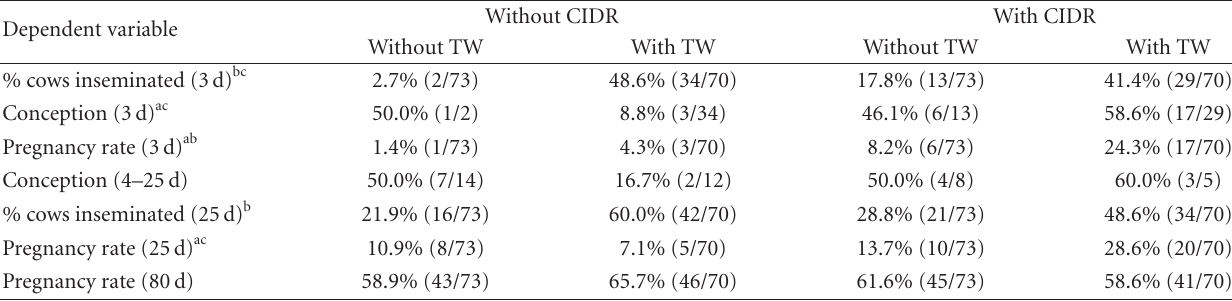
Table 1: Percentage of cows inseminated (first 3 d and 25d of breeding season), conception (first 3d and from d 4 to 25 of breeding season) and pregnancy rates (first 3d, 25d, and in 80d of breeding season) in anestrous Nelore ( Bos indicus ) × Angus ( Bos taurus ) crossbred cows treated or not treated with an intravaginal insert containing 1.9g of progesterone (CIDR) between days − 7 to 0 of breeding season and/or 48h temporary weaning (TW) between d 0 and 2 of breeding season. Adapted from Vasconcelos et al.